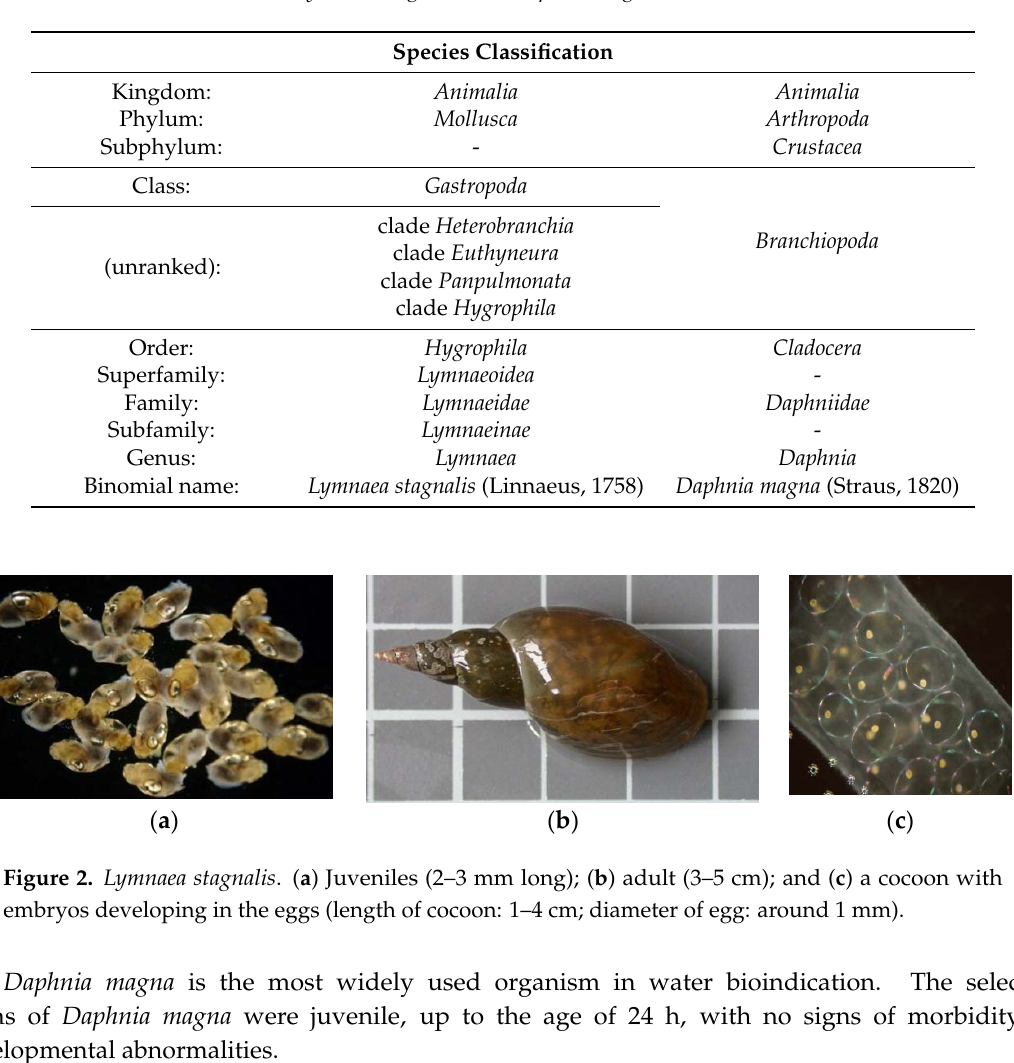
Table 1. Lymnaea stagnalis and Daphnia magna classification.